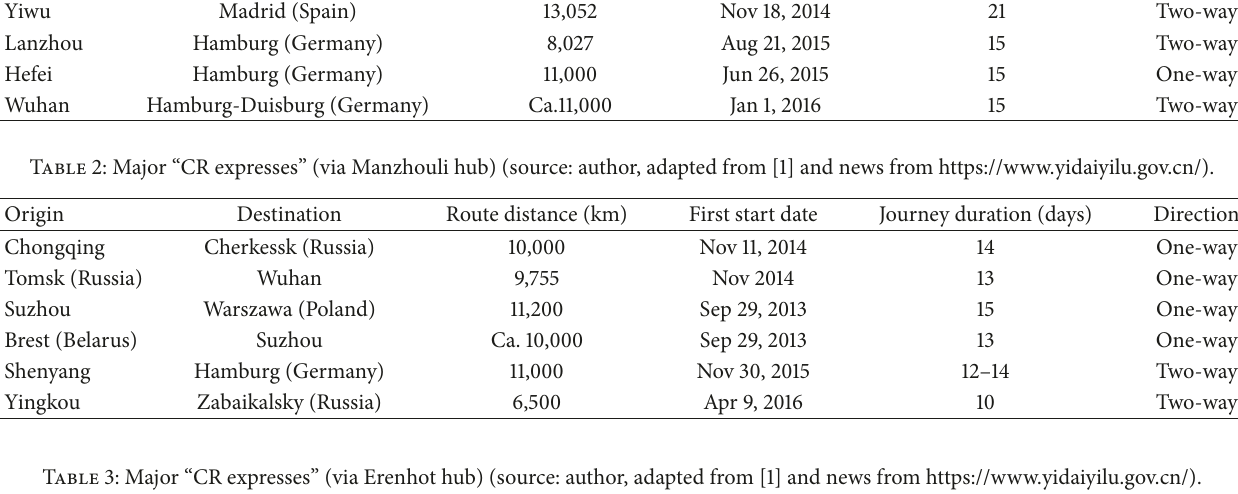
Table 3: Major “CR expresses” (via Erenhot hub) (source: author, adapted from [1] and news from https://www.yidaiyilu.gov.cn/). Origin